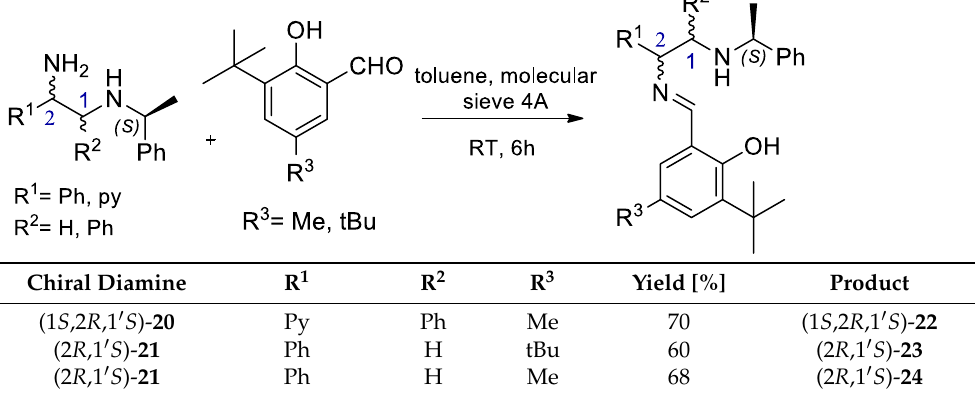
Table 2. Synthesis of chiral amino-aldimines.